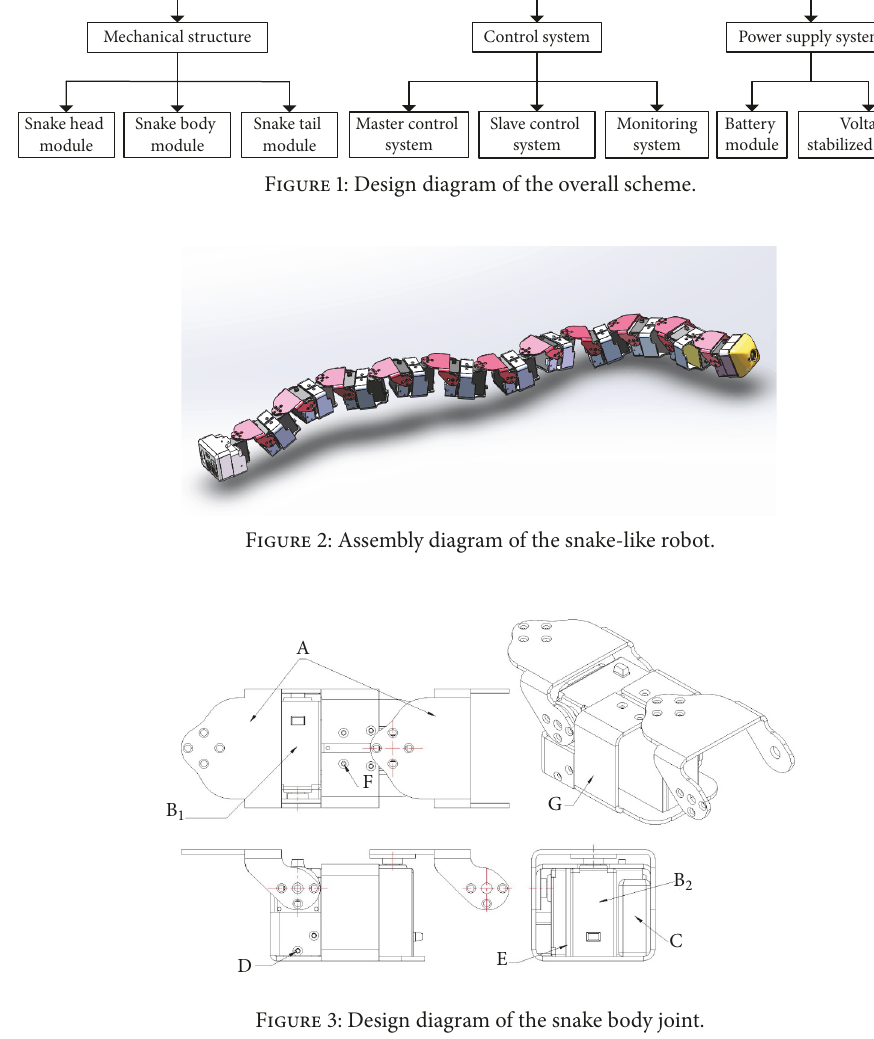
Figure 3: Design diagram of the snake body